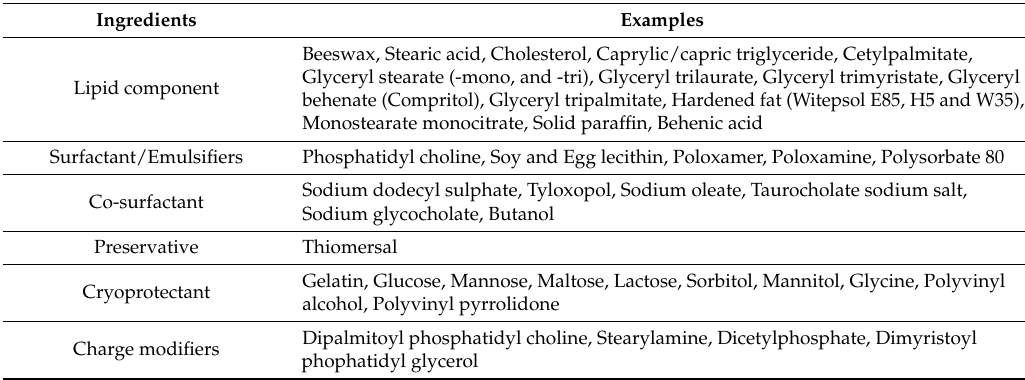
Table 1. Ingredients used in SLNs-based